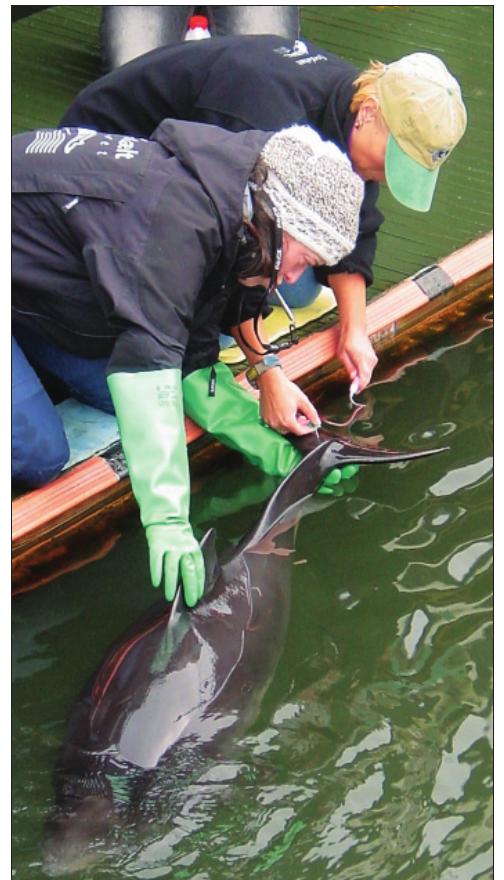
Fig. 2. Taking a blood sam- ple from a harbour por- poise at pool- side, Fjord&Bælt, Kerteminde, Denmark. (Photo: